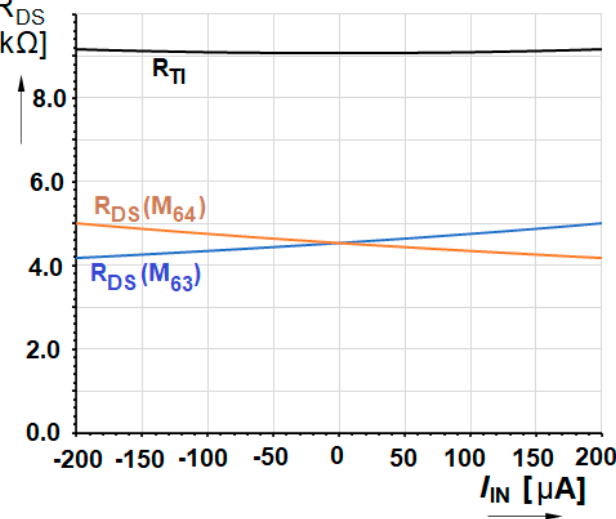
Figure 2. Differential transimpedance as the sum of the linear transistors R DS with their dependences on I IN calculated by Equation (5).